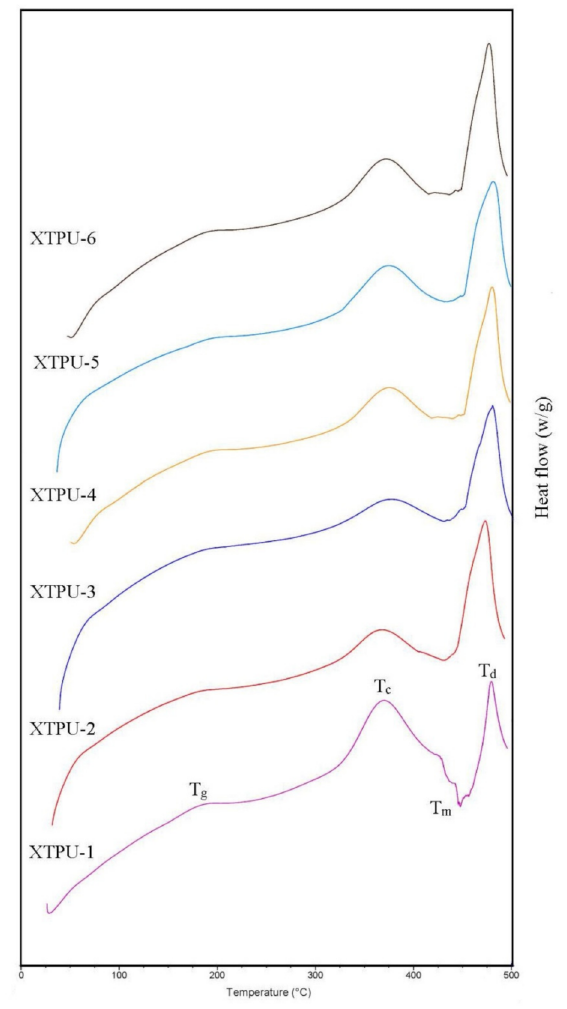
Figure 7. DSC curves of XTPU-1, 2, 3, 4, 5, and 6 at 500 ◦